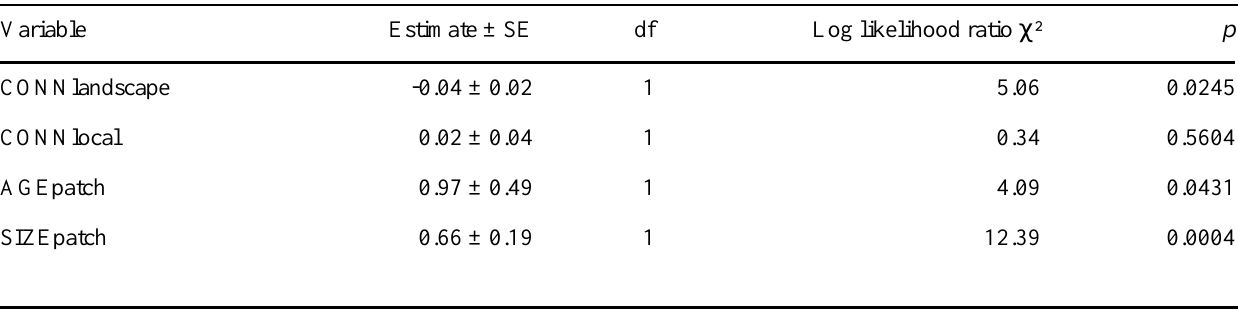
Table 1 . Full logistic regression model showing the relationship of the number of juvenile North Island robin visiting a patch during natal dispersal after leaving the natal patch on four landscape variables recorded for each patch. Whole model (df = 4, chi-square =38,36, p < 0.0001); CONN is short for connectivity.